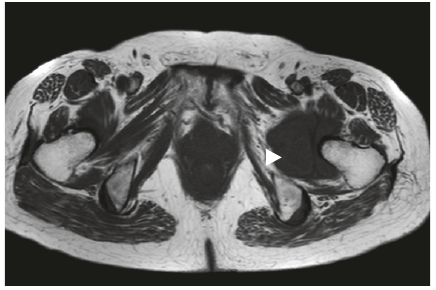
Figure 2: T1-weighted axial magnetic resonance image of the left hip joint. The extra-articular herniation sac is indicated by the arrowhead.